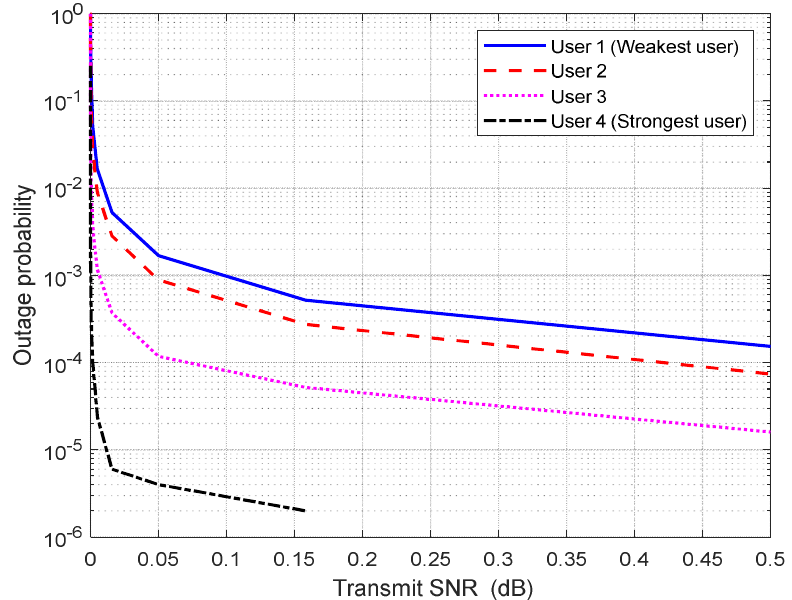
Figure 16. OP against SNR for four users with varying distances and BW 200 MHz for UL NOMA.